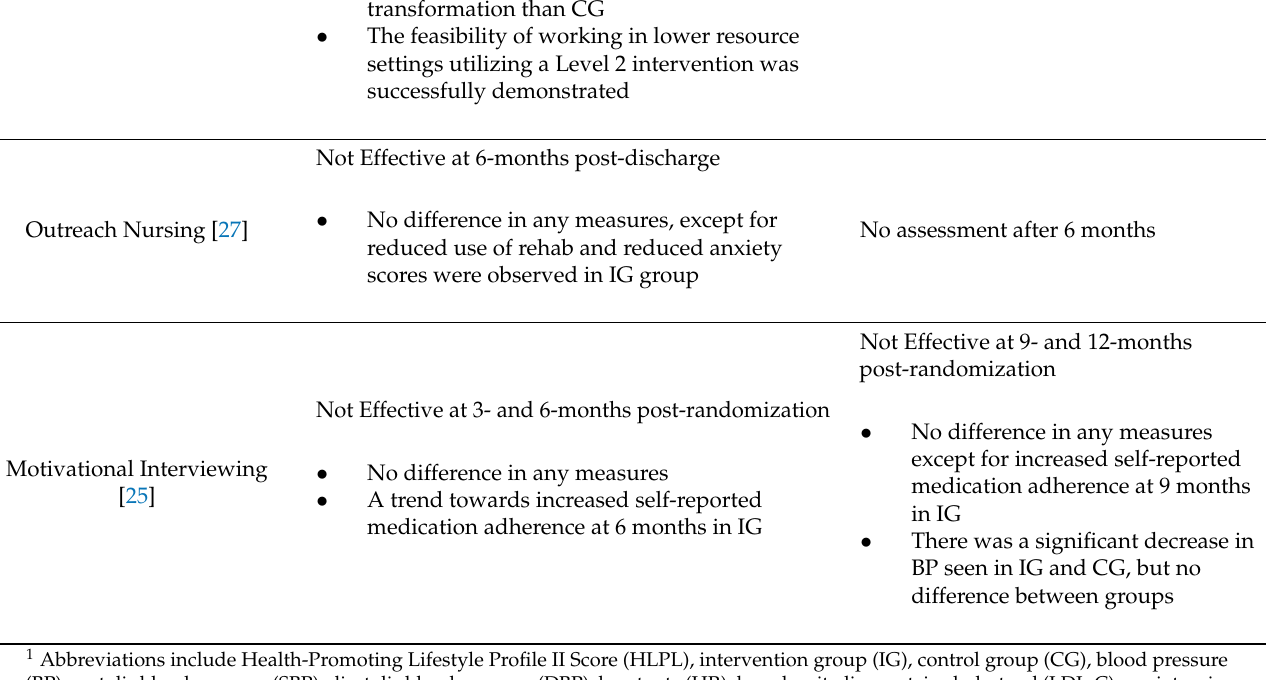
Table 4 provides a summary of intervention titles, year of publication, first author, sample size, study design, country of origin, intervention target population, level of intervention, setting of the intervention, provider of the intervention, and goal of the intervention for all studies included in the